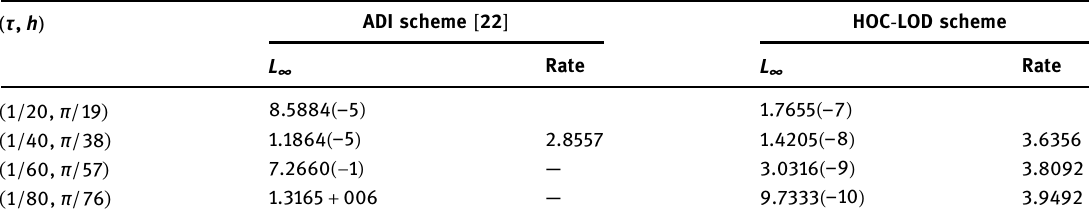
Table 9: L ∞ error when =